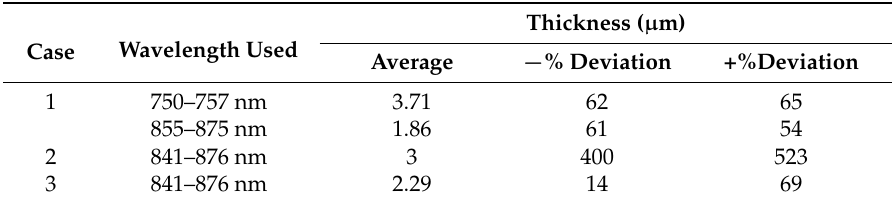
Table 4. Results from De Carolis et al. Using Specular